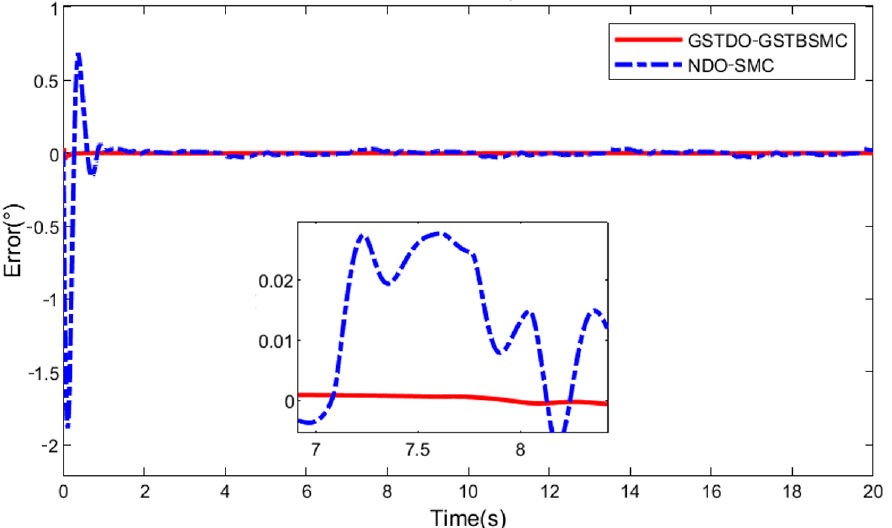
Figure 11. Comparison of the tracking error between GSTDO-GSTBSMC and NDO-SMC in Experi- ment 2.